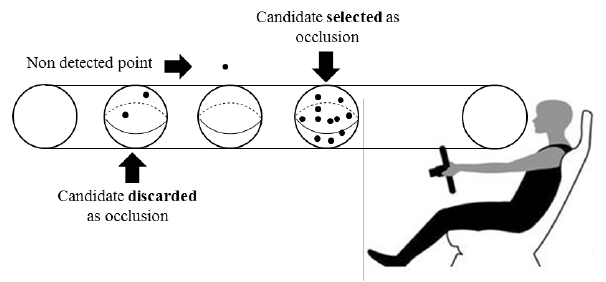
Figure 4. Different conditions in the occlusion for the algorithm.